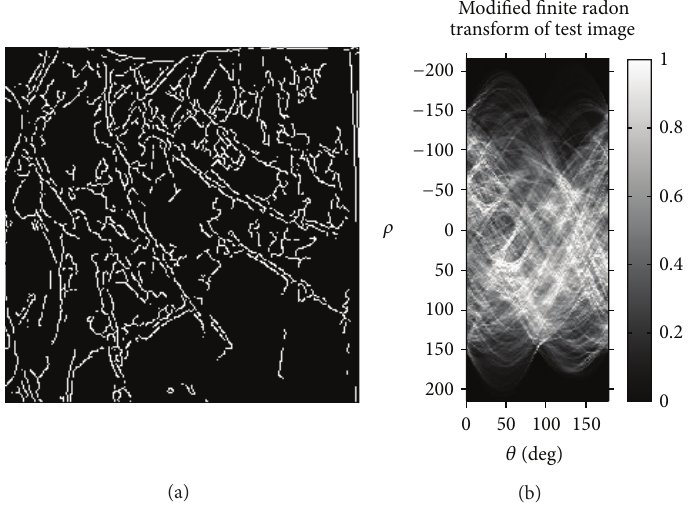
Figure 4: (a) Cropped and canny image and (b) MFRAT feature extraction.